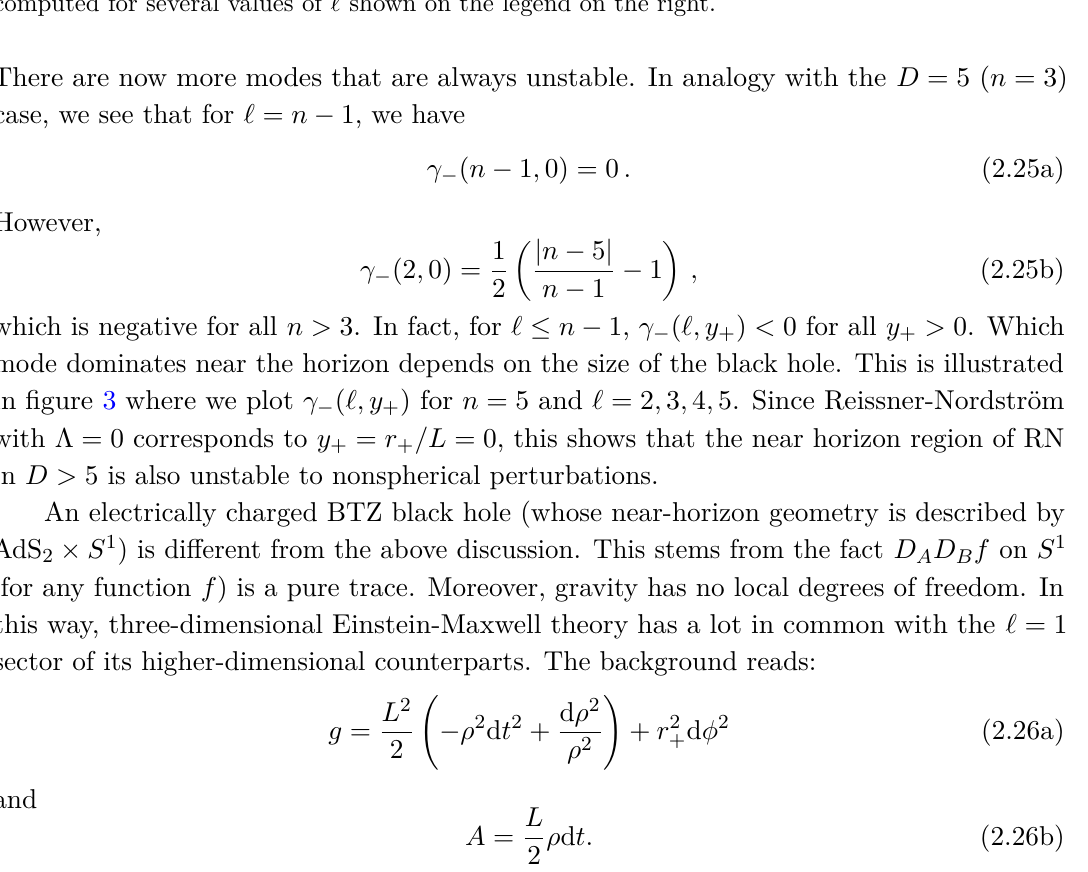
Figure 3 . The scaling exponents γ − for perturbations of AdS 2 × S 5 , as a function of y + = r + /L , computed for several values of ‘ shown on the legend on the